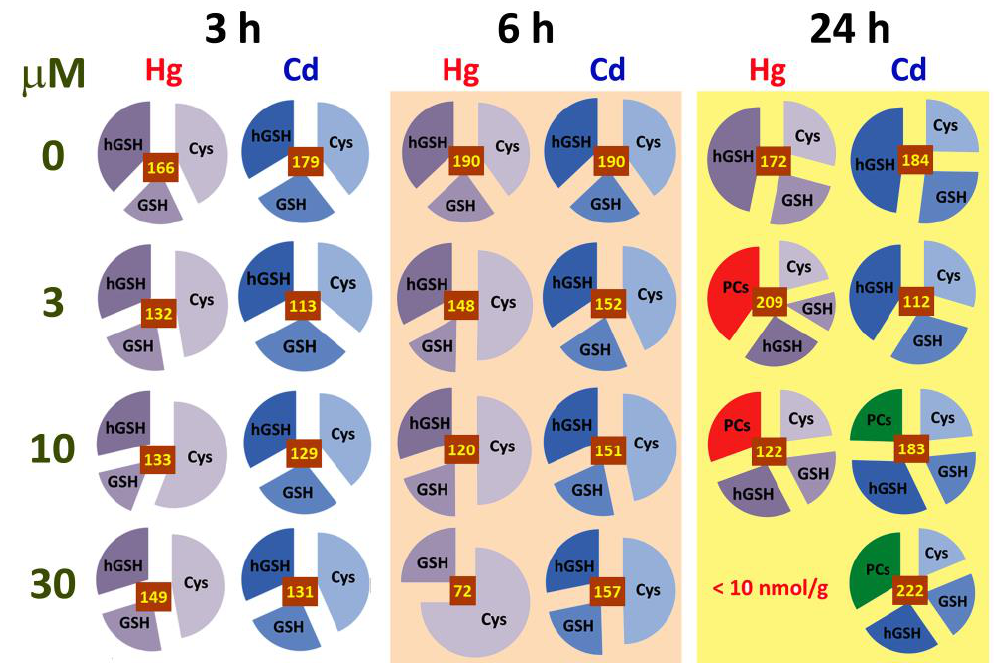
Figure 5. Biothiols profile in roots of alfalfa seedlings treated with 0, 3, 10, and 30 µ M Hg or Cd for 3, 6, and 24 h. The relative abundance of each biothiol type is represented: Cys, cysteine; GSH, glutathione; hGSH, homoglutathione; and PCs, phytochelatins. The numbers in the brown box represent the average total concentration of biothiols (nmol g −1 FW) in each treatment. Absolute values and statistics are shown in Supplementary Table S1.